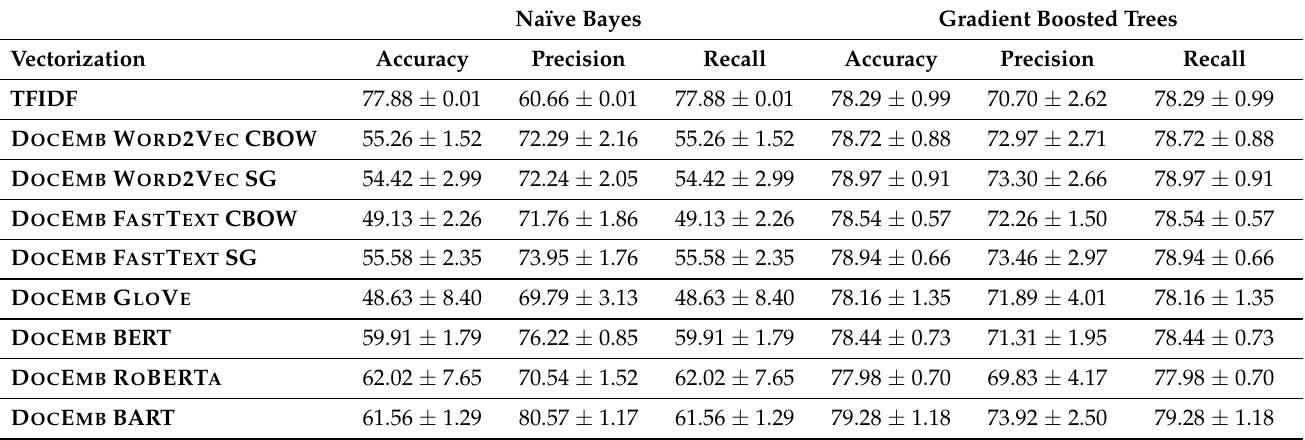
Table 6. Fake news detection results on the Buzz Feed News dataset as presented in Horne and Adali